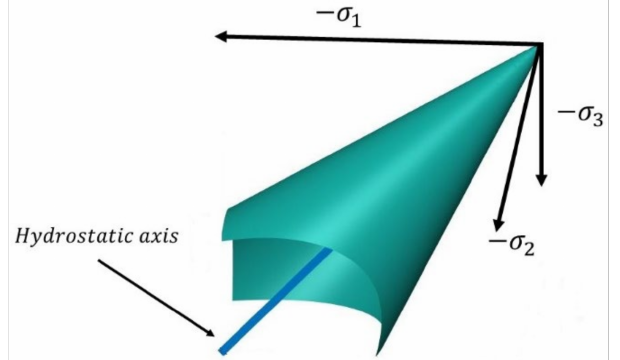
Figure 1. Failure curve surface.